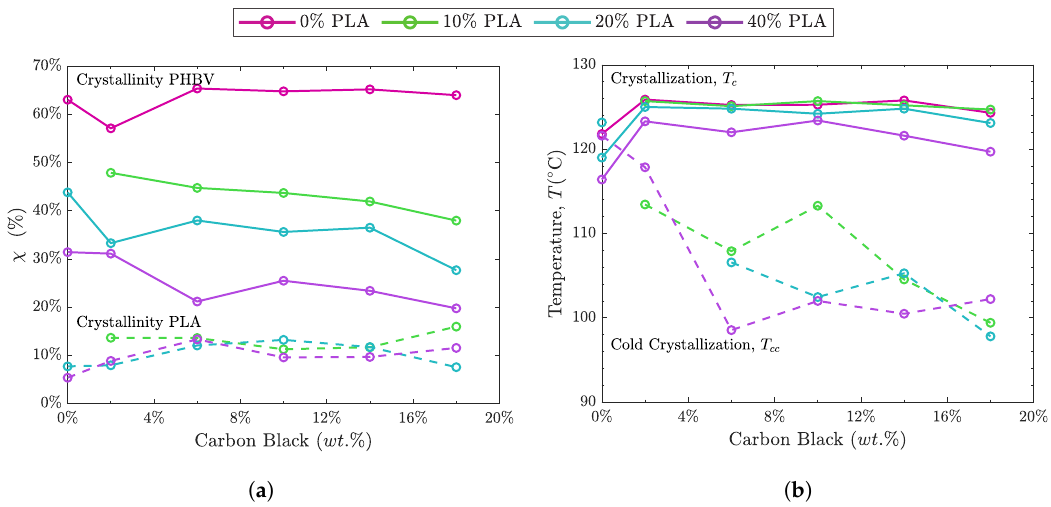
Figure 7. DSC results summarizing: ( a ) The percent crystallinity ( χ ) as determined through DSC for (solid lines) the PHBV phase of the blend and (dashed lines) the PLA phase of the blend. The impact of the vol.% of the polymer within the blend is more significant in determining crystallinity than the wt.% of CB; ( b ) the shift in crystallization temperature, T c , with increasing CB for the PHBV phase of the blend (solid lines) and the shift in cold crystallization temperature, T cc , for the PLA phase of the blend (dashed lines). For the PLA phase, T cc decreases with increasing wt.% of CB.